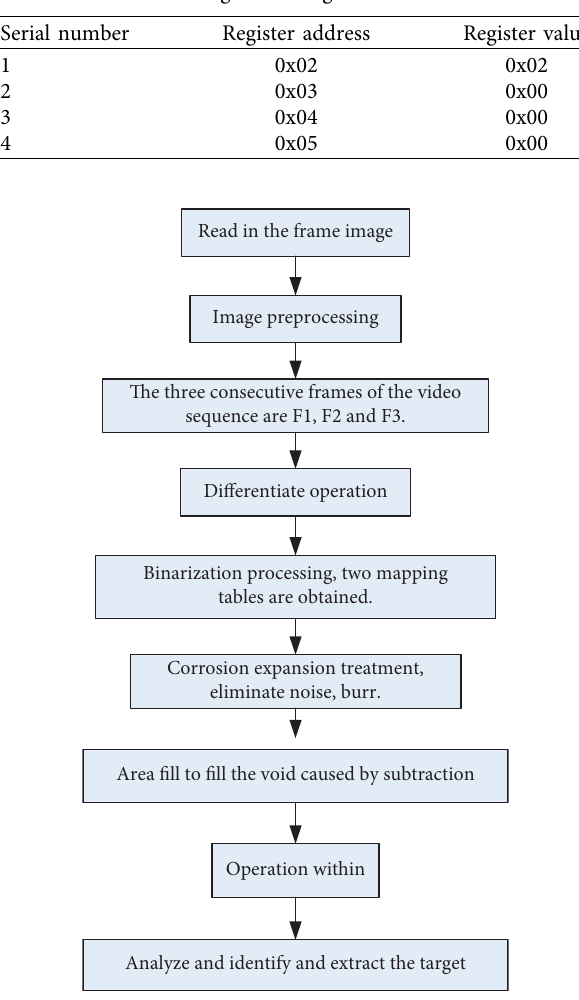
Figure 1: Flow chart of vehicle detection